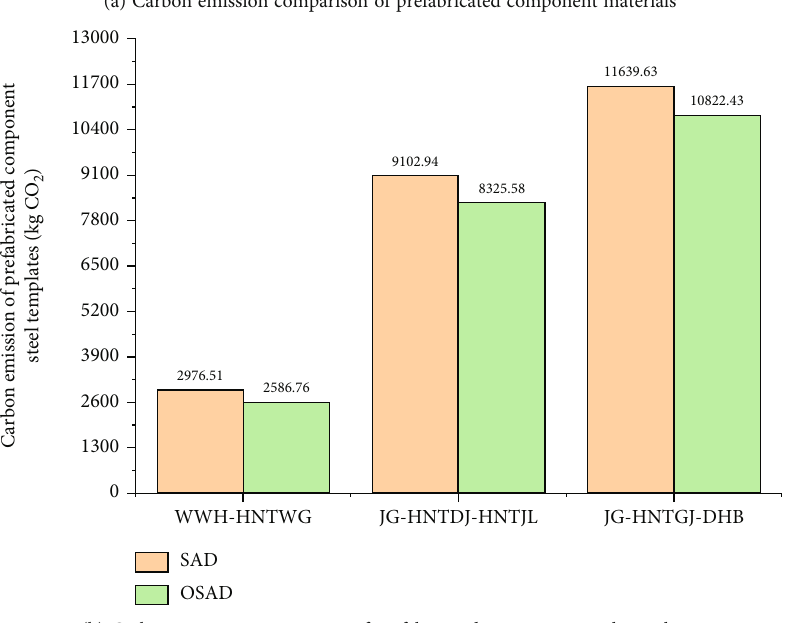
(b) Carbon emission comparison of prefabricated component steel templates Figure 6: Carbon emission comparison of prefabricated component materials and